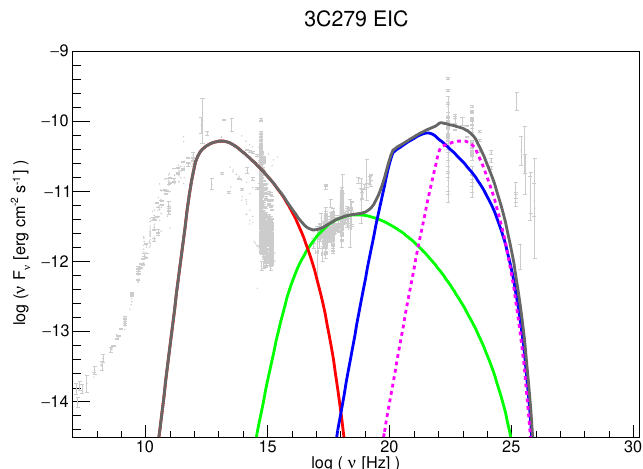
Figure 3. Spectral energy distribution of the flat spectrum radio quasar 3C279, showing in gray archival data from the SSDC SED builder (https://tools.ssdc.asi.it/SED/). One-zone external-inverse-Compton modeling of the SED, with in red synchrotron emission by electrons; in green synchrotron-self-Compton emission; in blue EIC emission over dust photons; and in pink EIC emission over Ly α photons. Parameters are δ = 30, R = 1.3 × 10 16 cm, B (cid:48) = 1.5 G, γ (cid:48) n 2 = 3.5, L e = 7 × 10 44 erg s − 1 , u (cid:48)